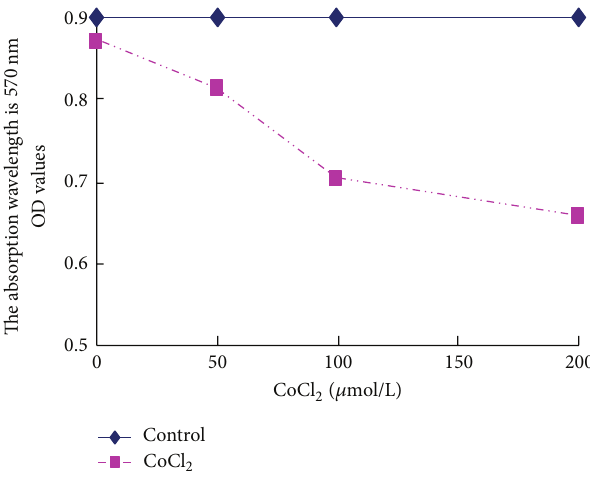
Figure 1: Effects of CoCl 2 with various concentrations on cell via- bility in cultured